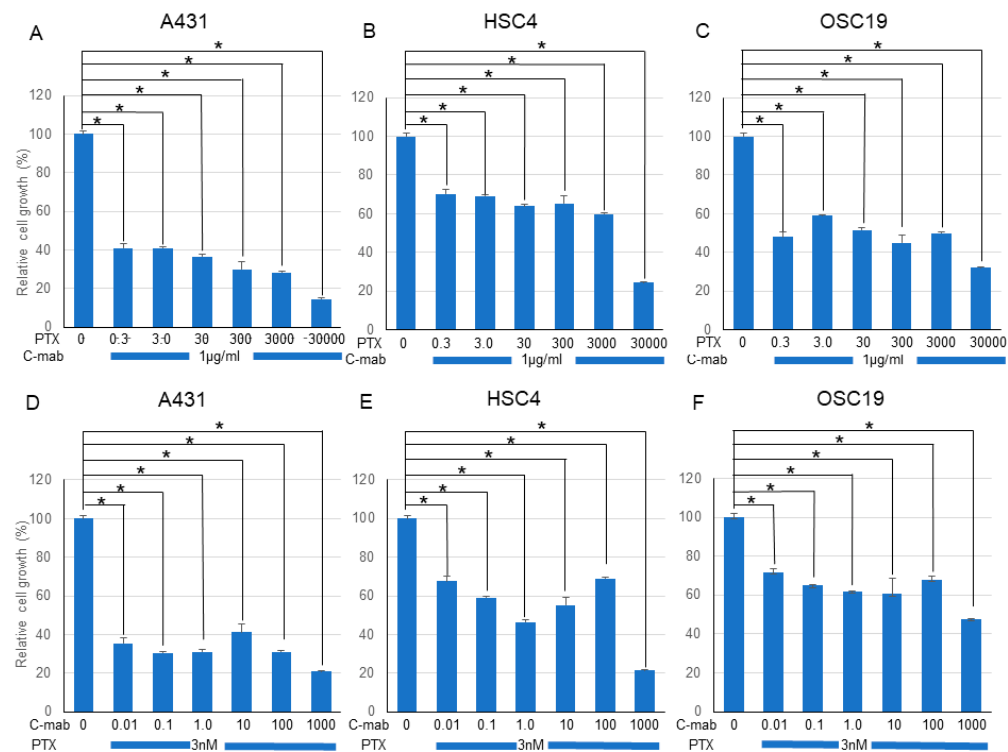
Figure 2. E ff ect of PTX and C-mab combinatory treatment to A431, HSC4, and OSC19 cell lines. Relative cell growth with PTX and C-mab combinatory treatment of each cell lines are shown. ( A – C ) C-mab concentration is fixed to 1.0 µ g / mL and PTX conditions are adjusted from 0.3 to 30,000 nM. ( D – F ) PTX concentration is fixed to 3.0 nM and C-mab conditions are adjusted from 0.1 to 1000 µ g / mL. Statistical analysis was performed by one-way ANOVA with Tukey’s multiple comparison test as a post hoc analysis. *: p < 0.05. The values shown are the mean of three determinations; bars: standard deviation. The data shown is a representative from three independent experiments with similar results. Int. J. Mol. Sci. 2020 , 21 , x FOR PEER REVIEW